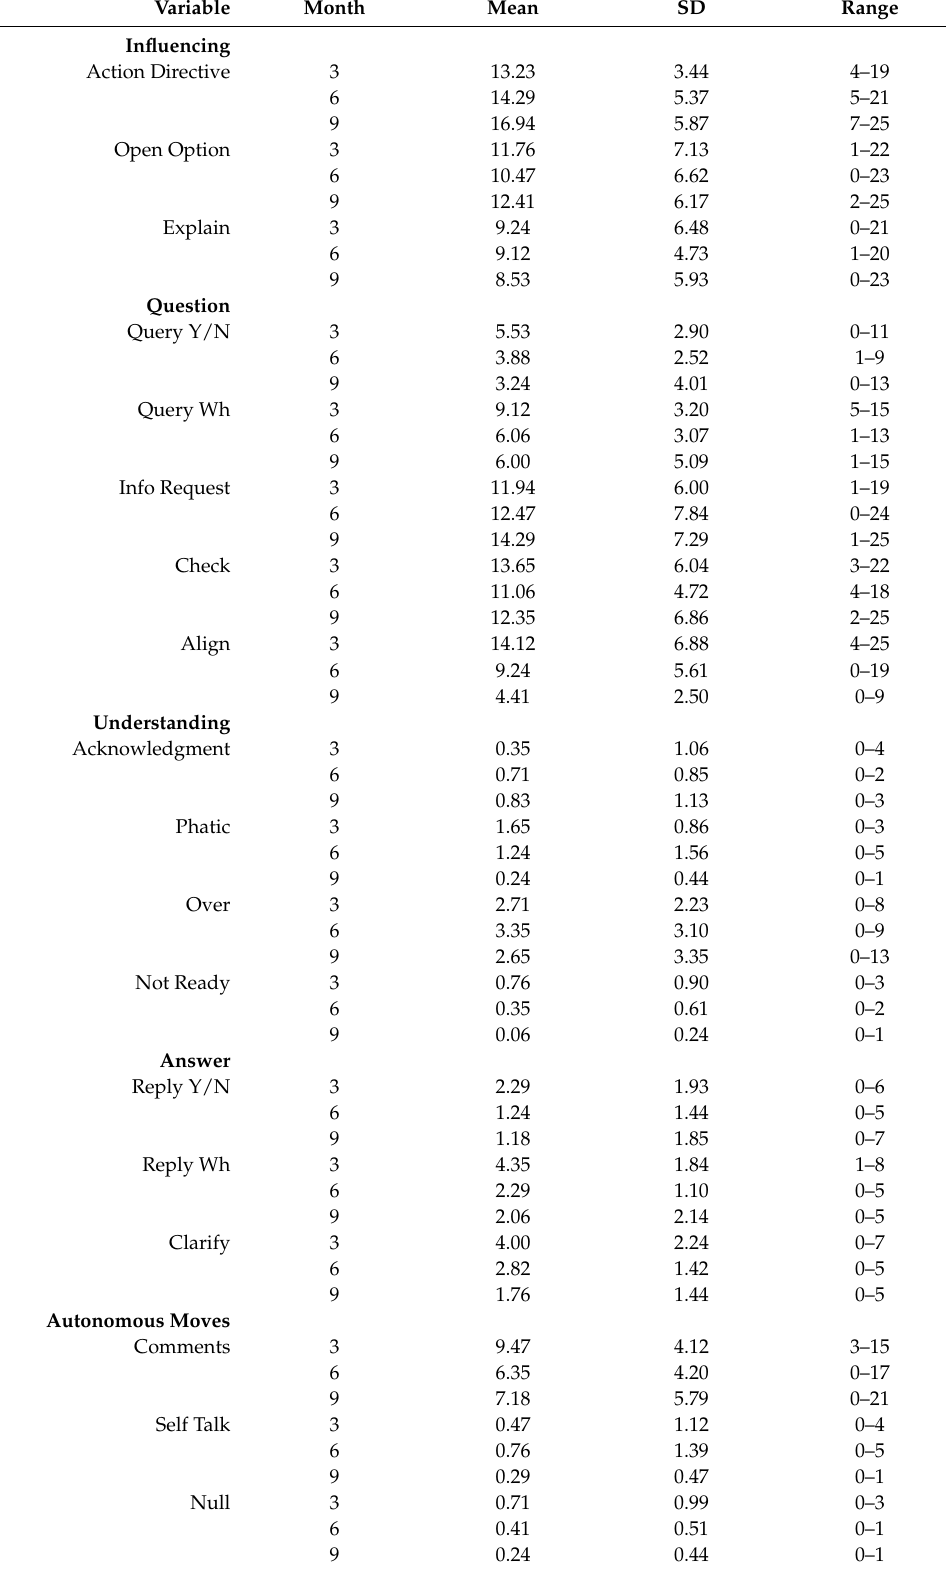
Table 2. Codification of